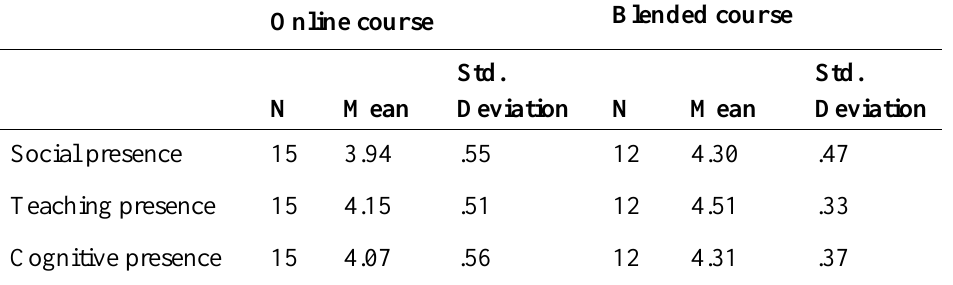
Students’ Perceptions of CoI Elements in both Courses Online course Blended